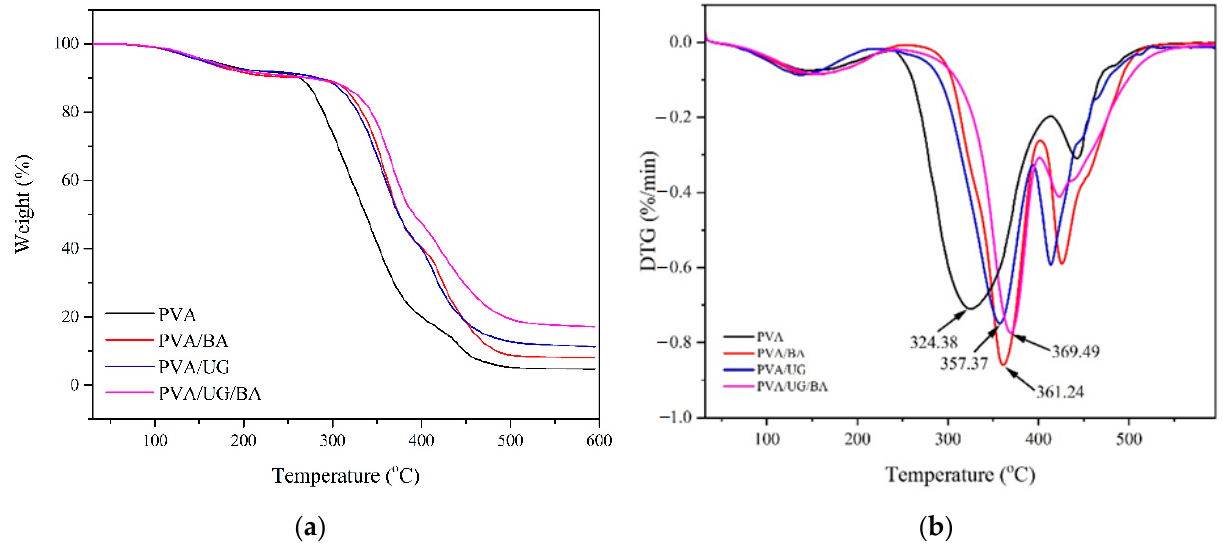
Figure 5. Thermal properties (TGA ( a ) and DTG ( b ) for PVA and blends.